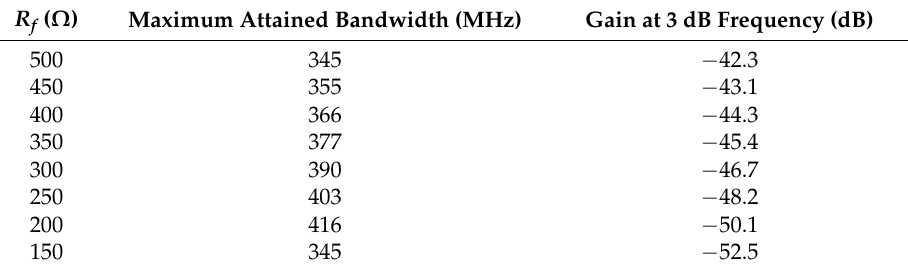
Table 10. Effect of varying the feedback resistance R f .